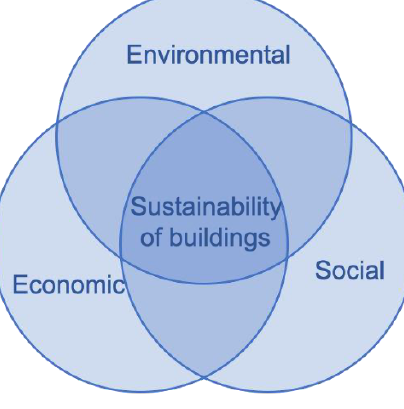
Figure 1: Three pillars of building sustainability (source: author)